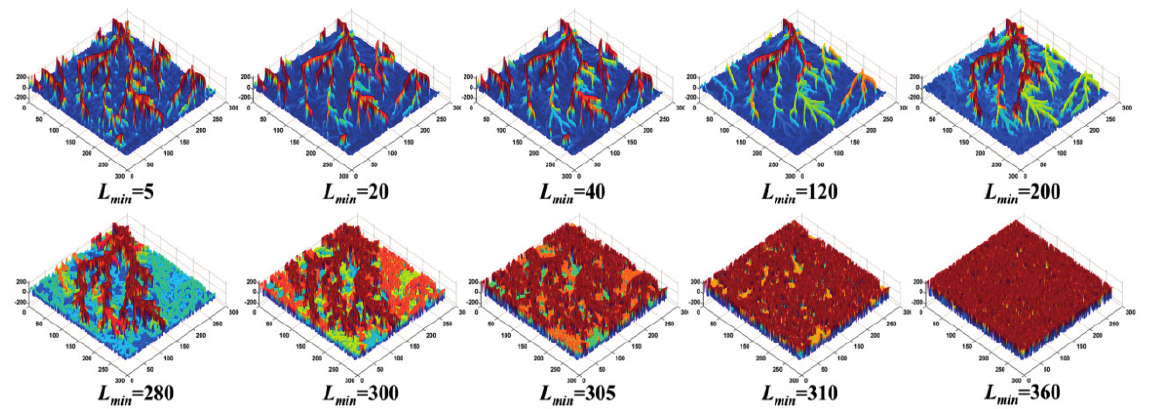
Figure 6. Three-dimensional views of the images in Figure 5 after path opening processing with different L min